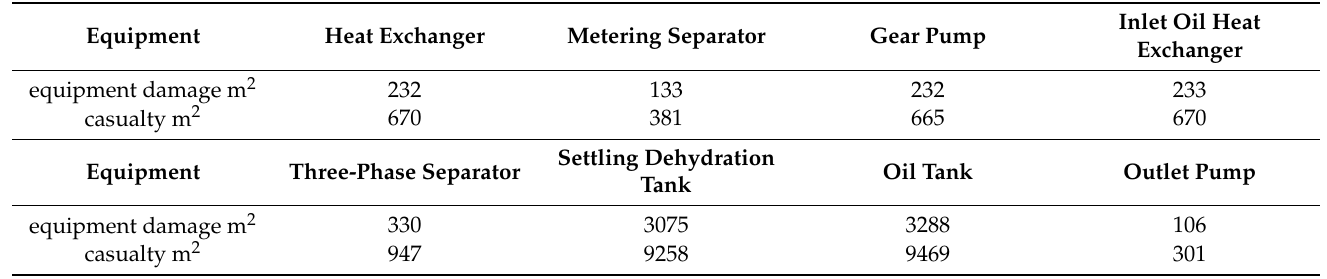
Table 13. Simulation results.